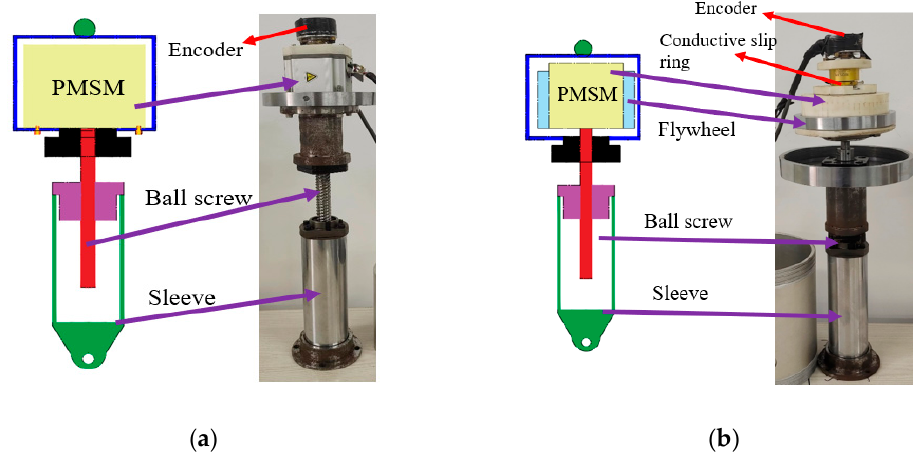
Figure 5. Prototype of VEI–VD device: ( a ). VD device; ( b ). VEI device.